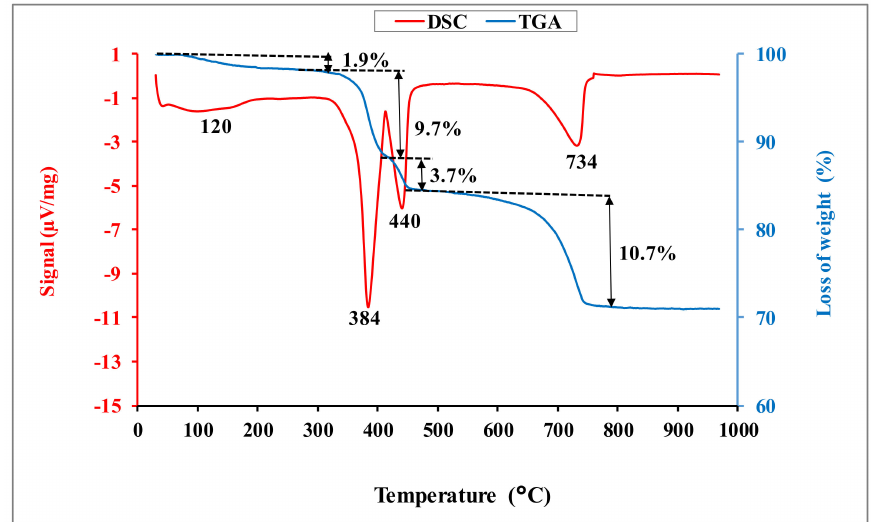
Figure 3. DSC-TGA curves of the dolomitic lime.